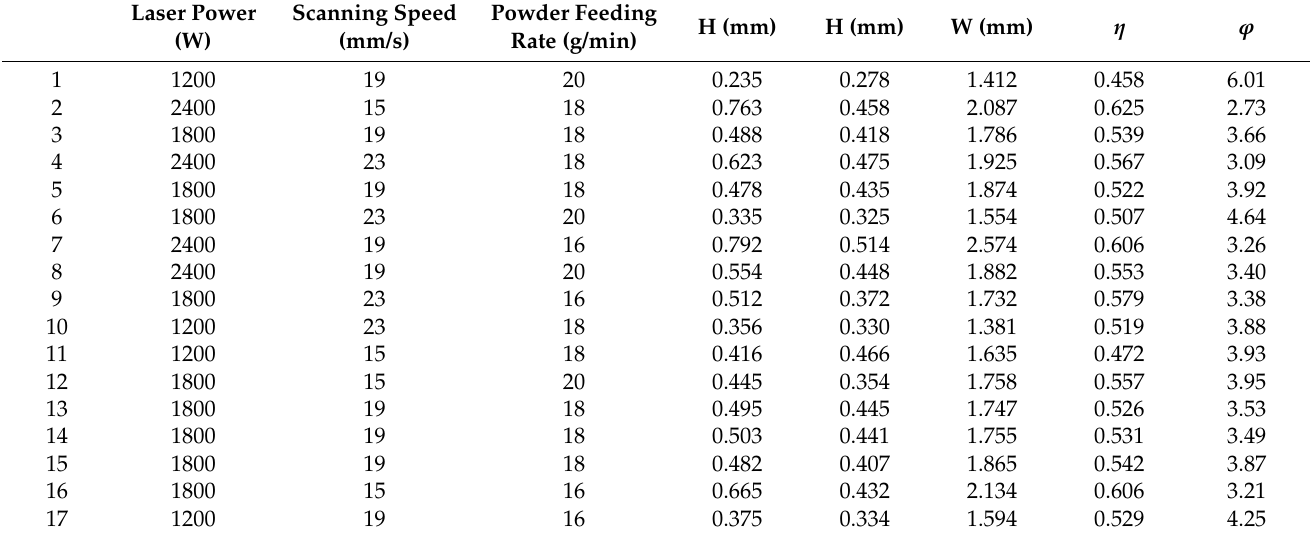
Table 5. Experimental scheme and